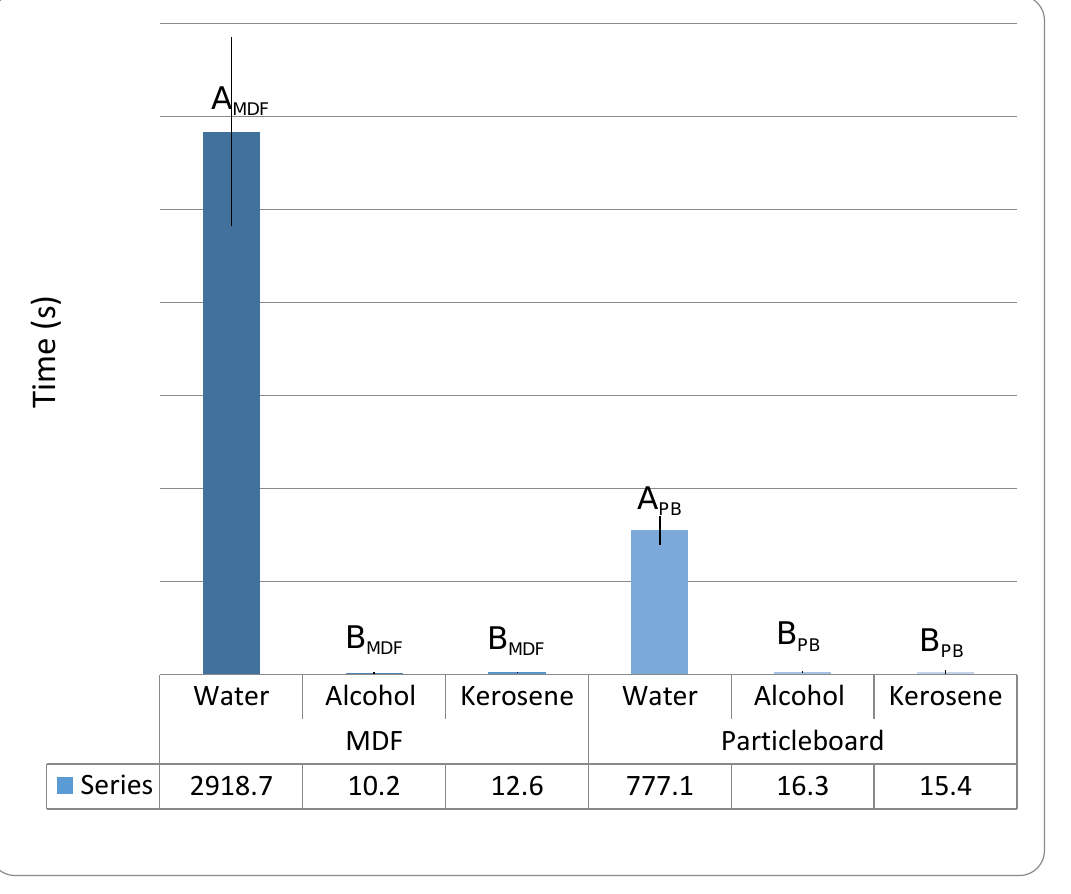
Figure 3. Penetration time for one drop of each of the three liquids (water, ethanol, and kerosene) to fully disappear from the surface of wood-based composite specimens (letters on each column represent Duncan’s multiple range test, α = 0.05, separately carried out for either MDF or particleboard). MDF = medium-density fiberboard; PB = particleboard.